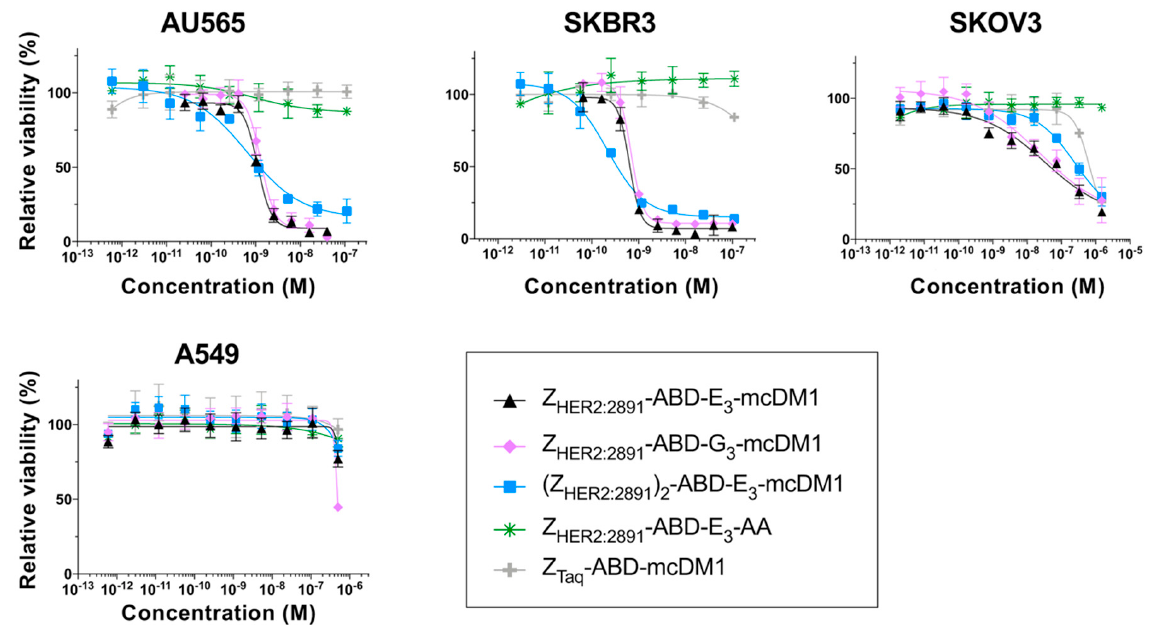
Figure 2. In vitro cytotoxicity analysis of the conjugates. The cytotoxicity was determined by incubating serial dilutions of the conjugates with the cell lines indicated above the panels. The relative viability of the cells is plotted on the Y-axis as a function of the conjugate concentration on the X-axis. The relative viability of cells cultivated in complete medium was used for normalization to 100% viability. Each datapoint corresponds to the average of four independent experiments and the error bars correspond to 1 SD.